Question: Write a single sentence explaining what this figure depicts.
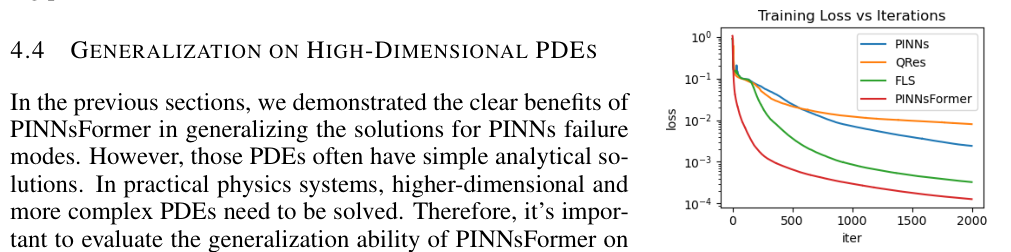
Answer: Training loss vs. Itera- tions of PINNs and PINNsFormer on the Navier-Stokes equation.